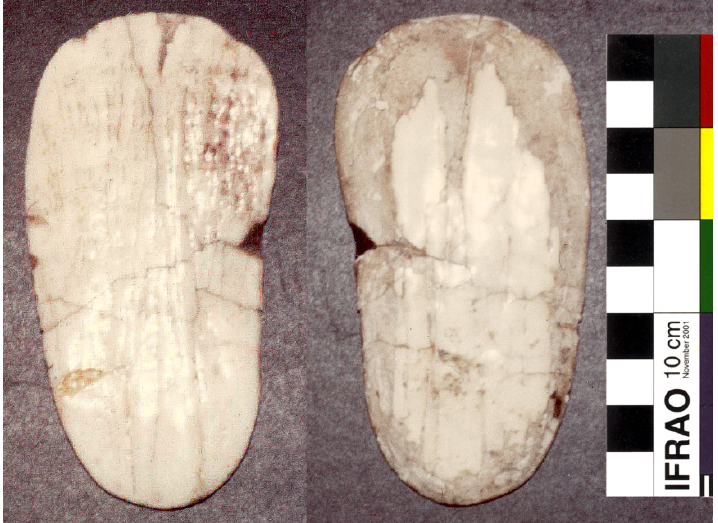
Figure 6. Both views of a polished and beveled lamella of a mammoth molar, formerly coated in ochre, from the Mousterian deposit of Tata,